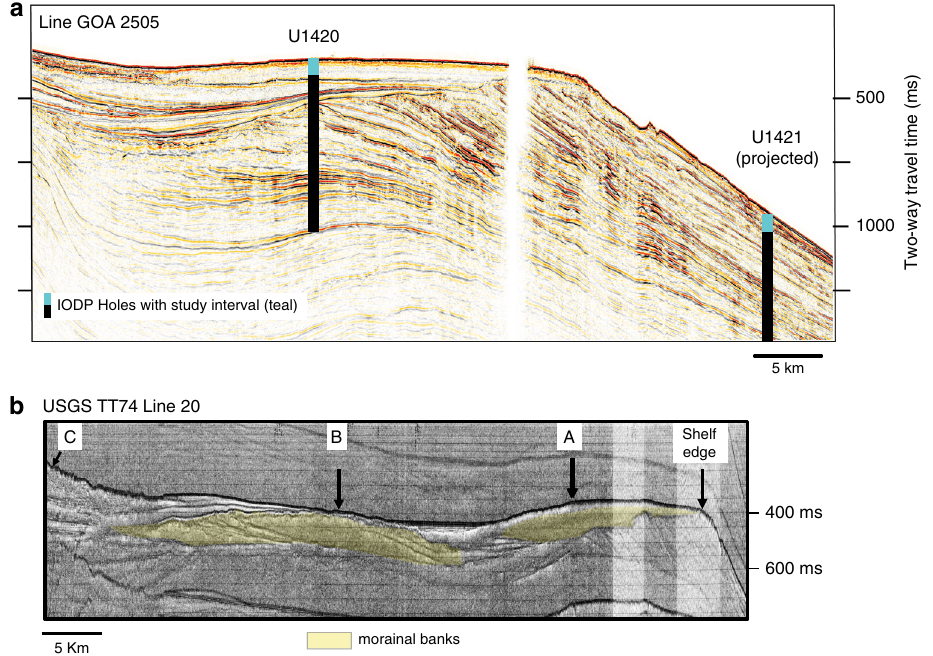
Fig. 3 Seismic pro fi les. a Summary diagram showing position of IODP site U1421 on the slope and site U1420 in the trough along line GOA2505. b Minisparker pro fi le USGS TT74 Line 2025 in Bering Trough illustrating morainal banks corresponding to different terminus positions mentioned in the text. U1421 is located ~4 km east of Line GOA2505.